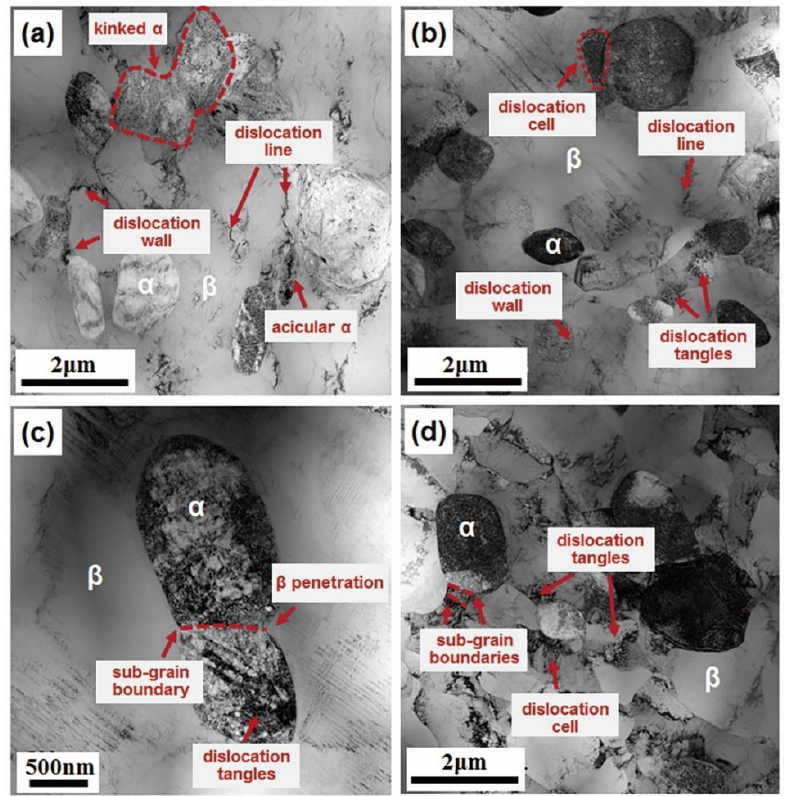
Figure 5. TEM micrographs for TB18 alloy deformed in the ( α + β ) phase zone: ( a ) 700 ◦ C/0.001 s − 1 , ( b ) 700 ◦ C/0.01 s − 1 , ( c ) 750 ◦ C/0.01 s − 1 , ( d ) 750 ◦ C/0.1 s − 1